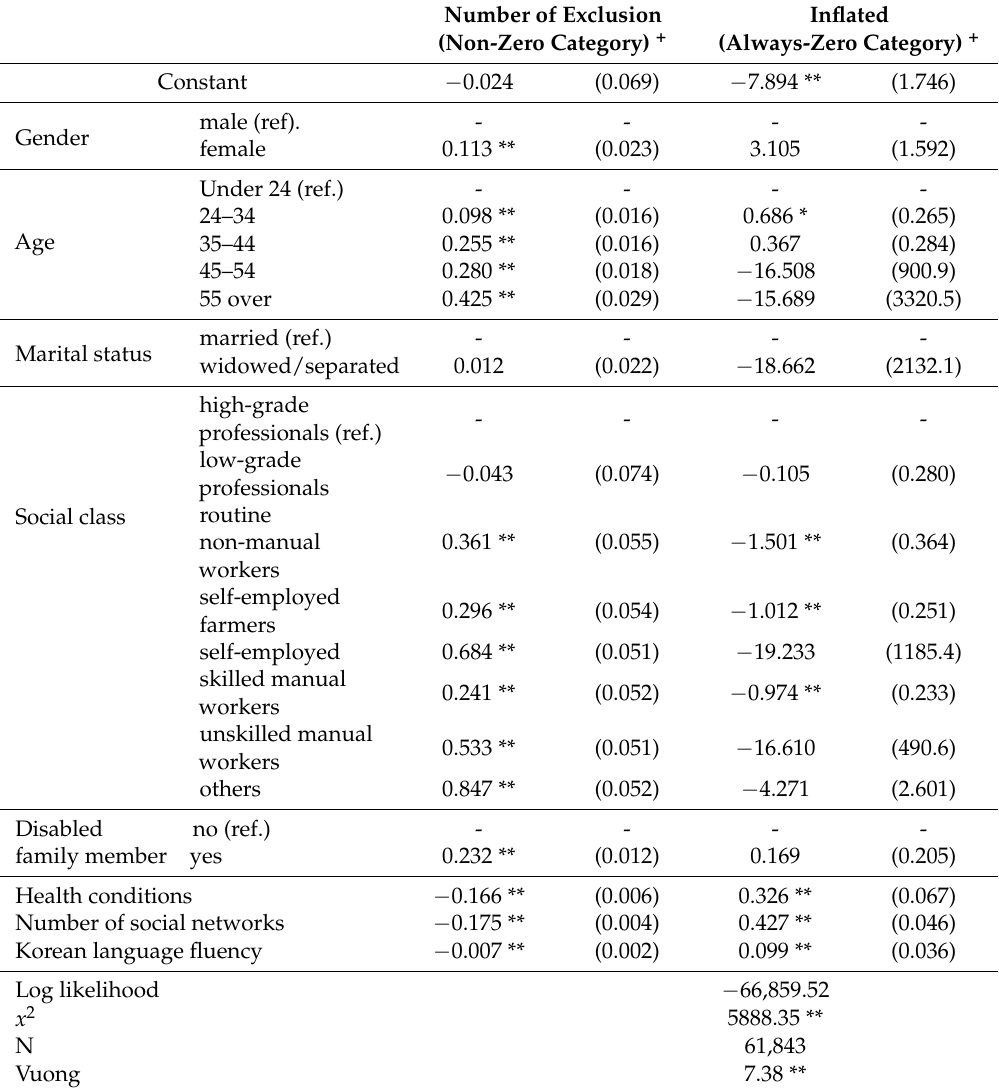
Table 3. Zero-inflated Poisson regression for the multiplexity of social